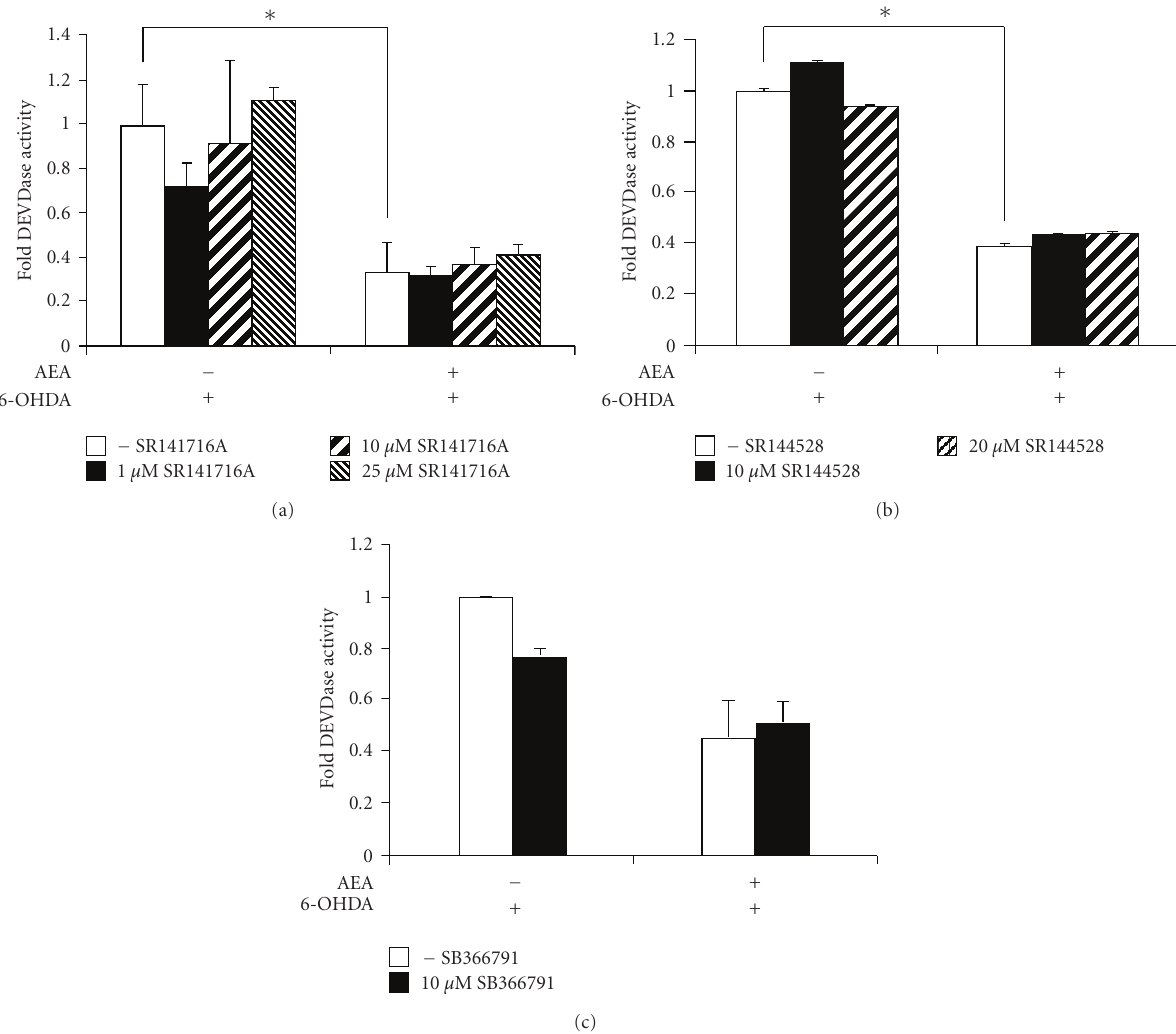
Figure 2: Anandamide-mediated prosurvival e ff ect is cannabinoid and vanilloid receptor-independent. PC12 cells were treated with 25 μ M anandamide for 24 hours, with or without selective receptor antagonists, and then exposed to 100 μ M 6-OHDA for a further 24 hours. E ff ector caspase activity was measured by DEVDase assay in whole cell extracts. (a) Indicated concentrations of CB 1 receptor antagonist SR141716A were added 1 hours prior to incubation with anandamide. Values represent the mean ± SEM of 3 independent determinations, ∗ P < . 001 . (b) Indicated concentrations of CB 2 receptor antagonist SR144528 were added 1 hour prior to incubation with anandamide. Values represent the mean ± SEM of 3 independent determinations, ∗ P < . 001 . (c) The TRPV1 receptor antagonist SB366791 at 10 μ M was added 1 hour prior to incubation with anandamide. The data shown are average of two separate experiments ±